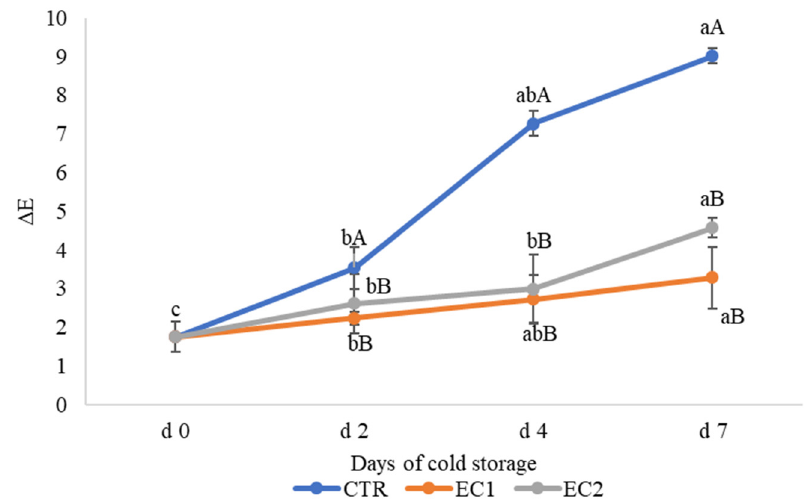
Figure 4. Development of colour variation ( ∆ E) of treated (EC1 and EC2) and untreated (CTR) pear slices. Data correspond to the means ± standard deviation of three replicates. Means with different letters are significantly different at p ≤ 0.05 using Tukey’s-HSD test. Different lowercase letters denote significant differences ( p < 0.05) among different sampling times for the same treatment. Different capital letters denote significant differences ( p < 0.05) between different treatments for the same sampling time.